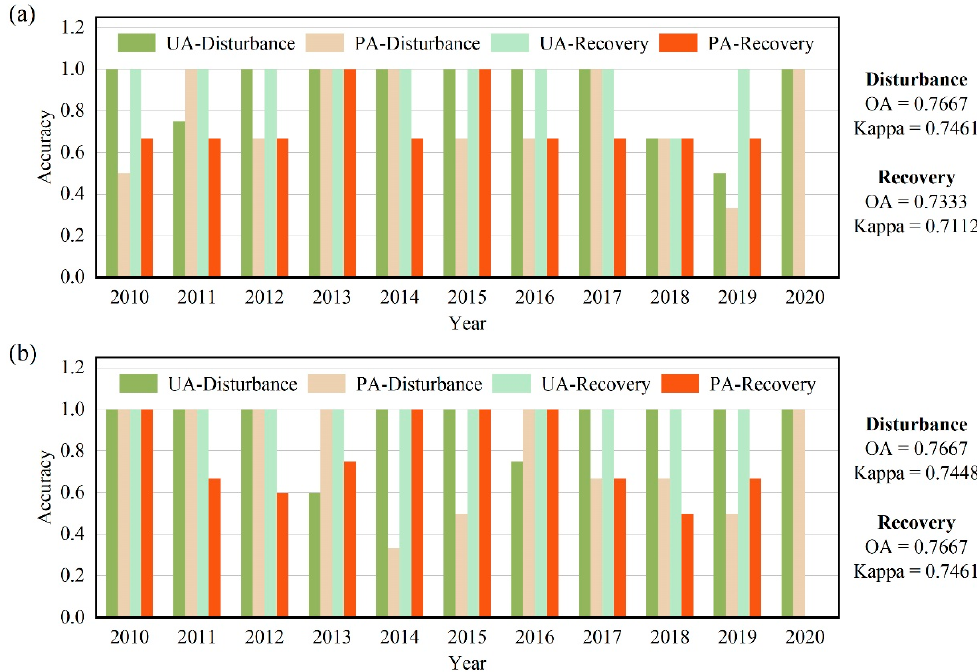
Figure 4. Accuracy of disturbance and recovery occurrence year identification between 2010 and